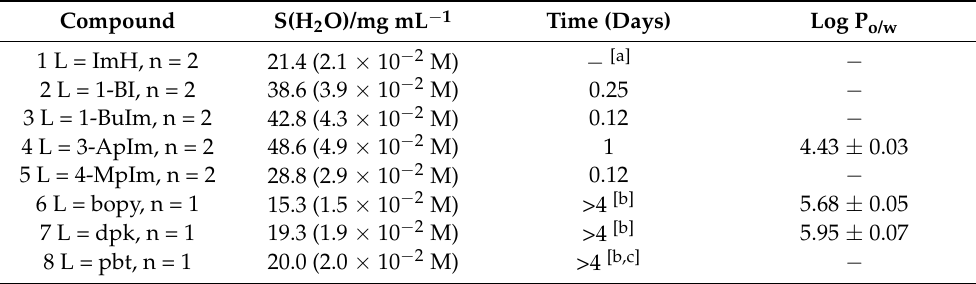
Table 3. Solubility and stability in water in presence of air at 25 ◦ C of complexes 1 – 8 and log P o/w -estimated values for complexes 4 , 6 , and 7